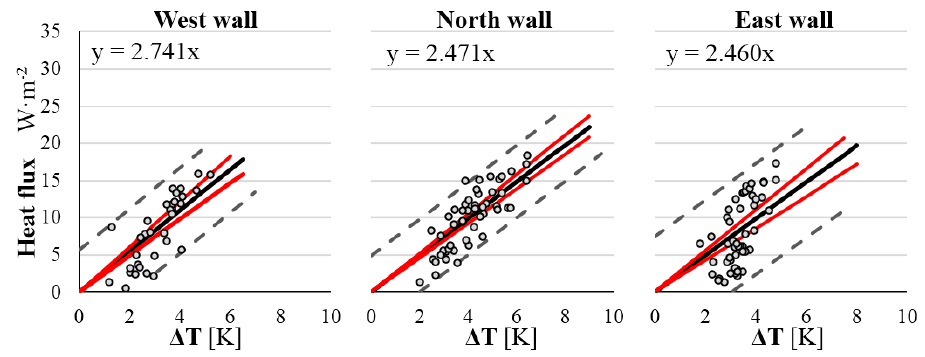
Figure 4. The convection heat transfer coefficient of the west wall (left figure), north wall (middle figure) and east wall (right figure) with confidence interval of 95% certainty (red lines). The Y-axis represents the convection heat transfer (Q Conv ) calculated by Equation (5). The X-axis represent the temperature difference between the indoor temperature and the interior wall surface ΔT = (T Indoor − T Small_wall ). The dashed lines represent 95% certainty for measurements to disperse around the mean (black trend-line).